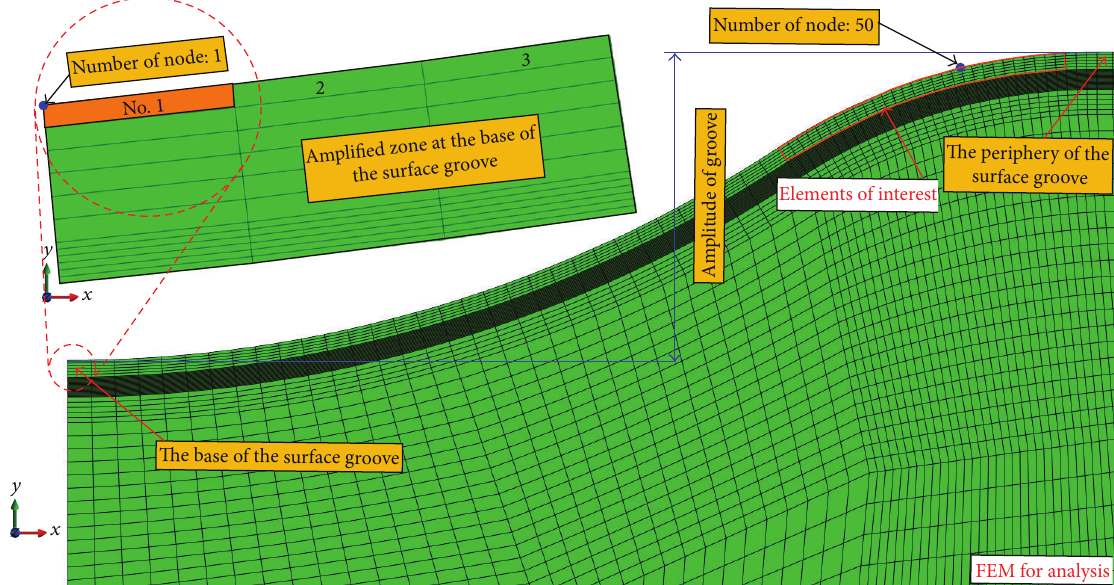
Figure6:TheFEMmodelandthedetailedmeshatthebaseofthesurfacegroove,aswellassomereferencegeometryforthelatterdescription.